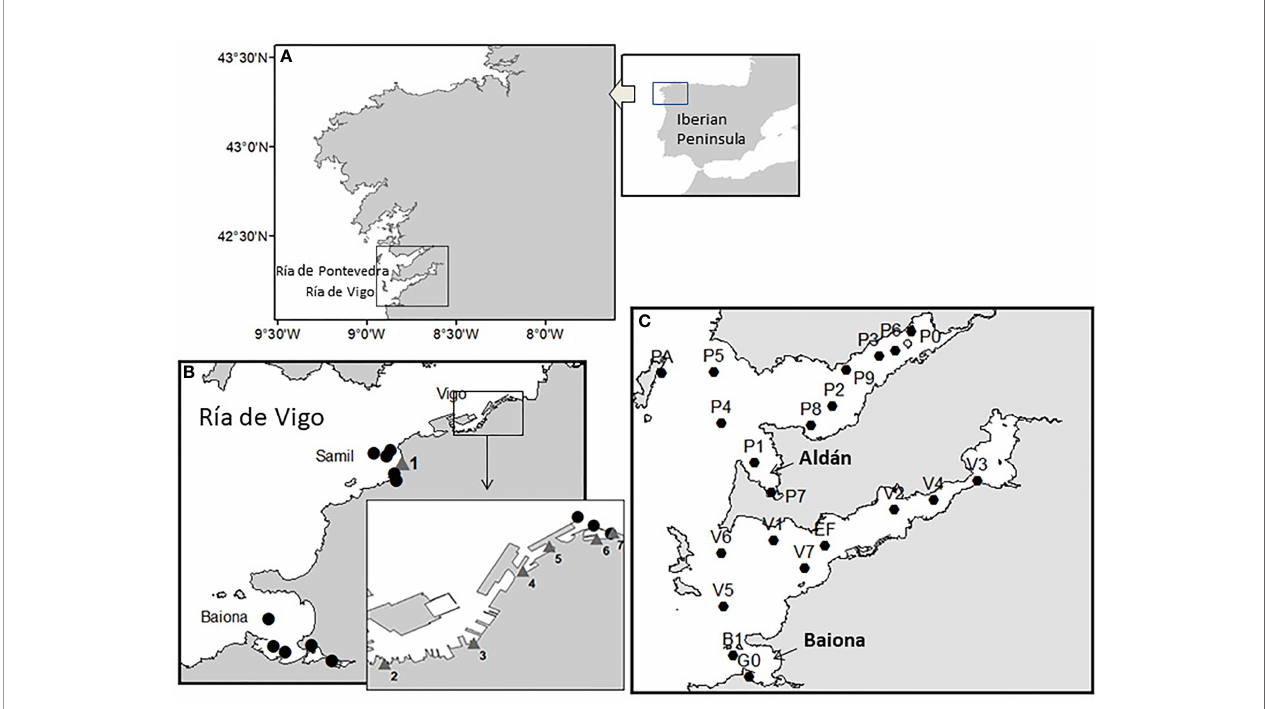
FIGURE 14 | Area of study for the Alexandrium minutum bloom in summer 2018 (Galicia, NW Spain). (A) R ı ́ as Baixas. (B) Sampling stations for cyst mapping (circles) and bloom seawater sampling locations (numbered triangles) in Vigo marina and Samil Beach. Fish and invertebrate samples for PSTs analyses were obtained from individuals collected next to 3 and 6. (C) Sampling stations of the Galician monitoring programme (INTECMAR) in the R ı ́ as de Vigo and Pontevedra.